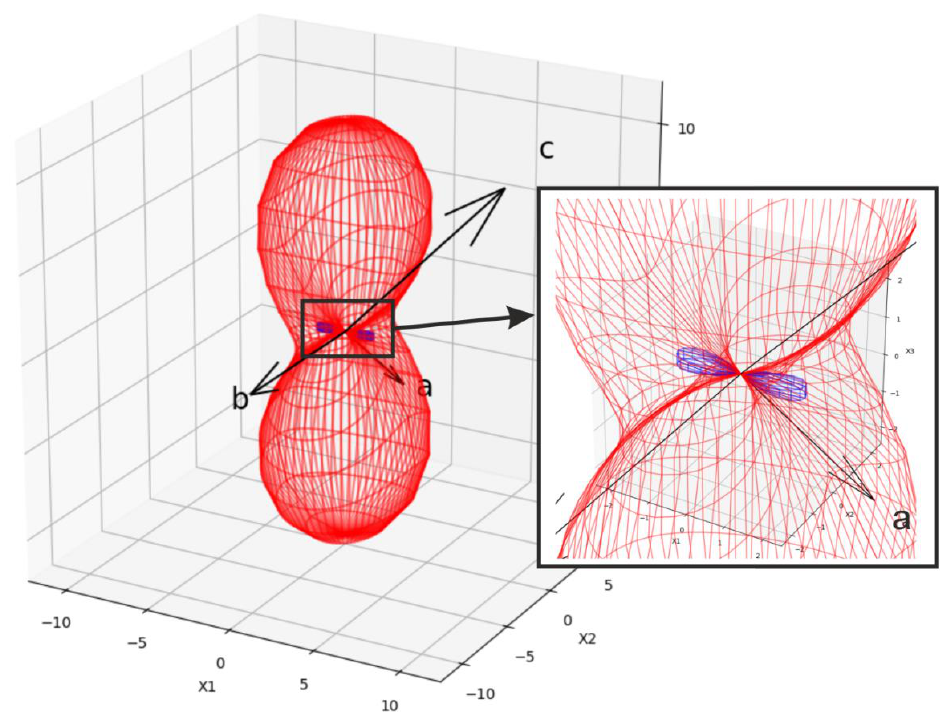
Figure 4. Thermal expansion tensor of Pr 2 (SO 4 ) 3 calculated for the temperature range of 30–150 ◦ C. Contraction is shown in blue color. Table 2. Main parameters of processing and refinement of the Pr 2 (SO 4 ) 3 8H 2 O sample.